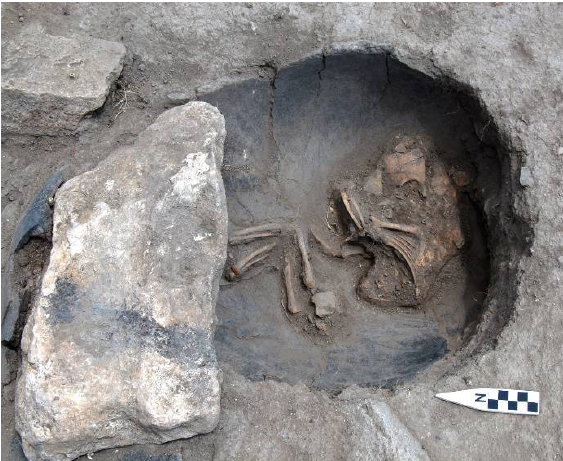
Figure 14. Photo of infant burial in jar (F100) near stone-stepped entry into the Western Compound Omphalos Building area. Note stone resting atop burial jar representing the uppermost stone step leading down to the courtyard.